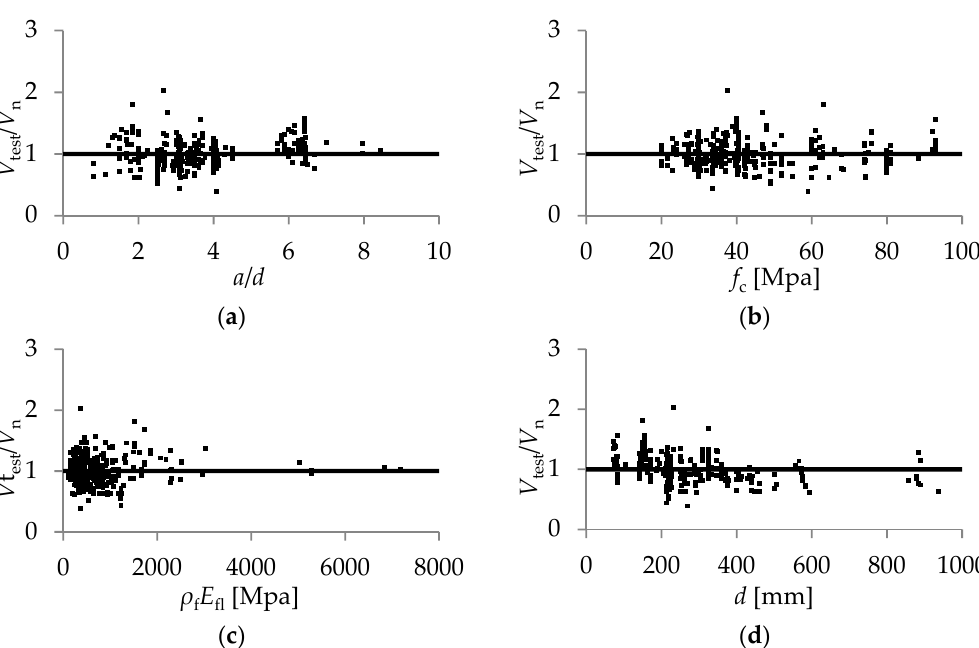
Figure 2. The ratio of the experimental and theoretical shear force V test / V n as a function of: ( a ) shear slenderness, a ⁄ d ; ( b ) the compressive strength of concrete, f c ; ( c ) the stiffness of the longitudinal reinforcement, ρ f E fl ; ( d ) the effective depth of cross section, d .